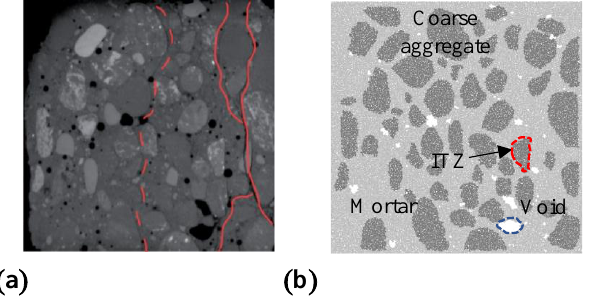
Figure 2. Concrete model. ( a ) Concrete specimen [15]; ( b ) concrete model.